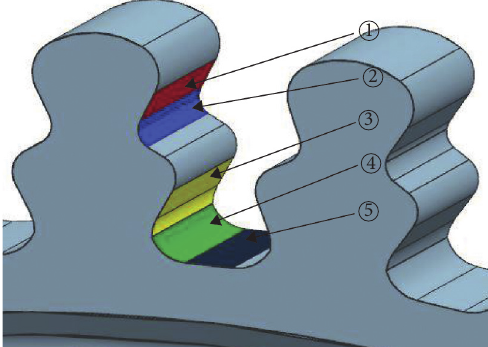
Figure 2: LSP area of turbine disk mortise.